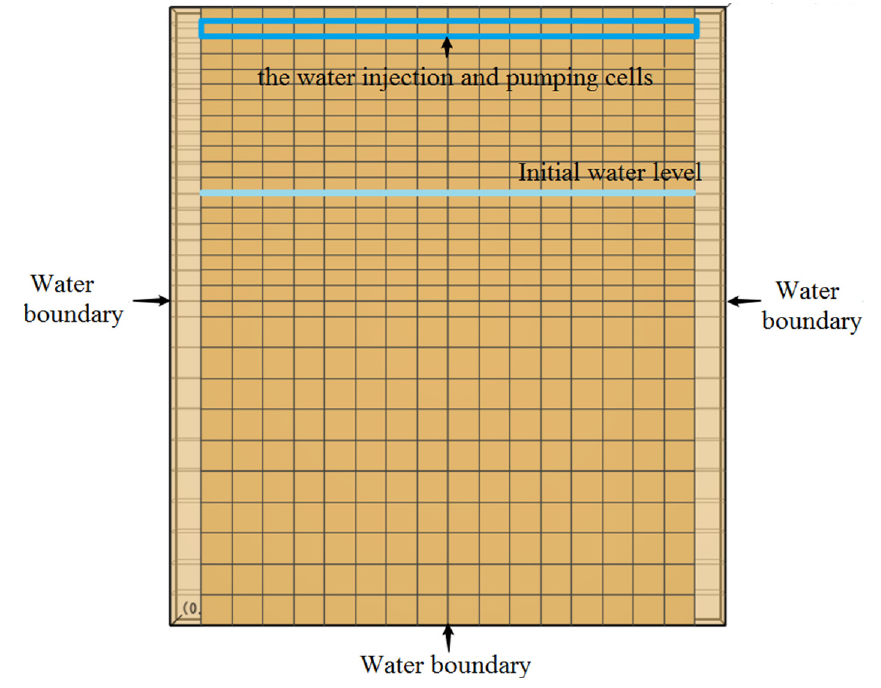
Figure 3. Water level control obtained by the TOUGH model.